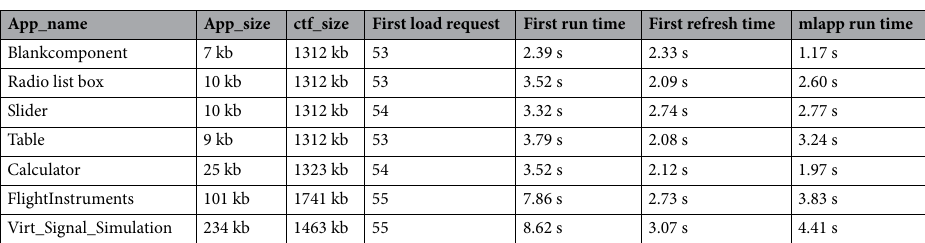
Table 1. Comparison of loading times of different